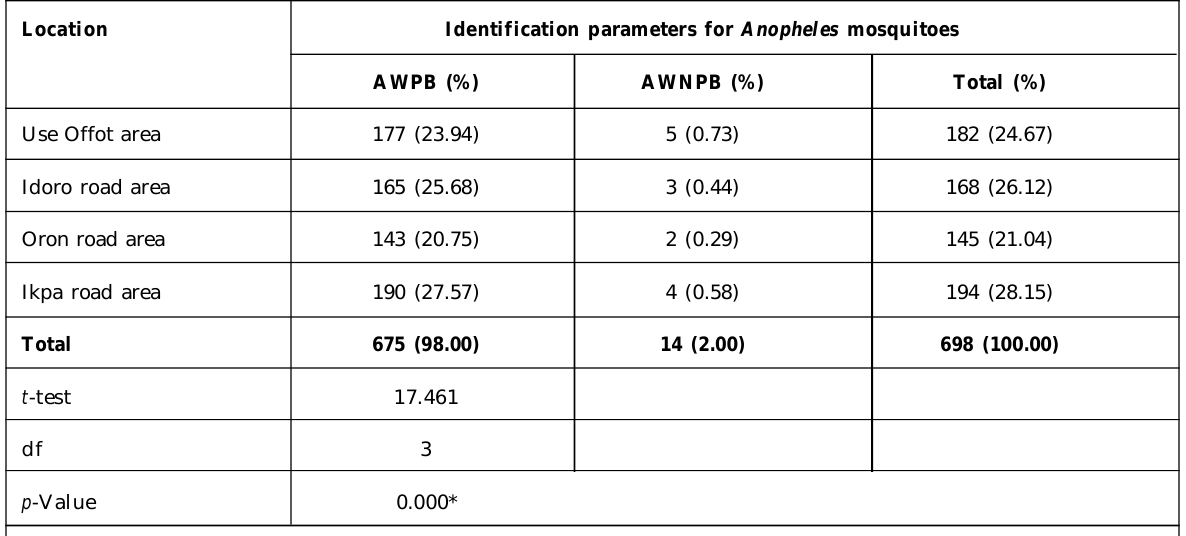
Table 1: Morphological characteristics of Anopheles mosquitoes from the study areas in Uyo Metropolis Location Identification parameters for Anopheles mosquitoes AWPB (%) AWNPB (%) Total (%) Use Offot area 177 (23.94) 182 (24.67) Idoro road area 165 (25.68) Oron road